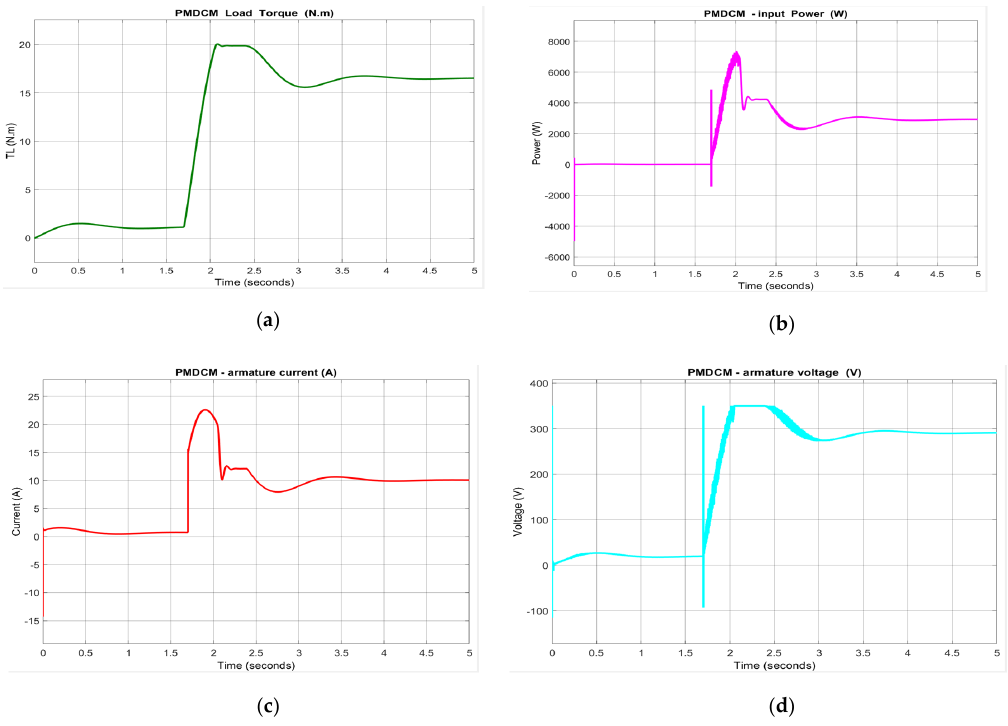
Figure 35. PMDCM—DC load. ( a ) PMDCM load torque; ( b ) PMDCM input absorbed power; ( c ) PMDCM armature current; ( d ) PMDCM armature voltage.